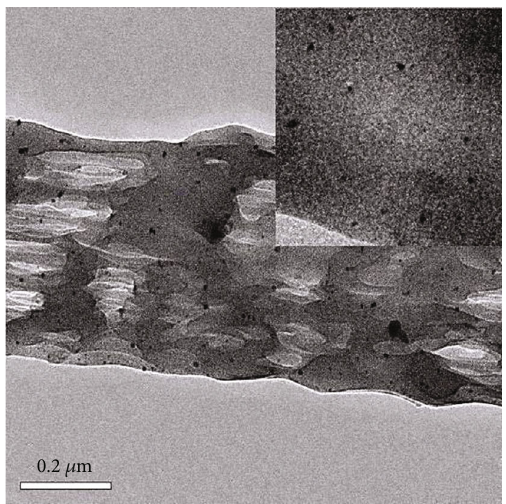
Figure 5: TEM of the POM/ β -CD micro fi bers ’ fi lm 30wt.% β